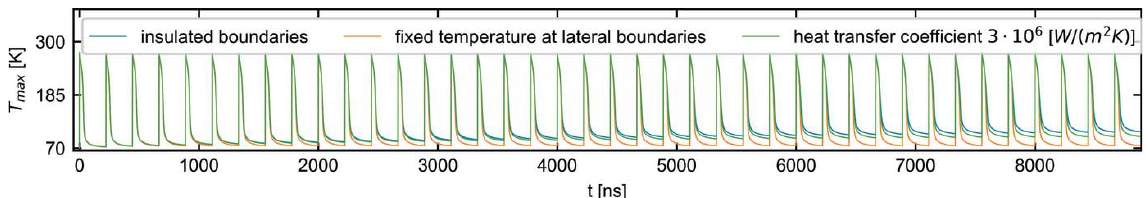
Figure 2 Development of the maximum temperature for a periodic heat load with repetition rate of 4.5 MHz, considering different thermal boundary conditions. The initial temperature of the cylindrical diamond crystal is T 0 = 70